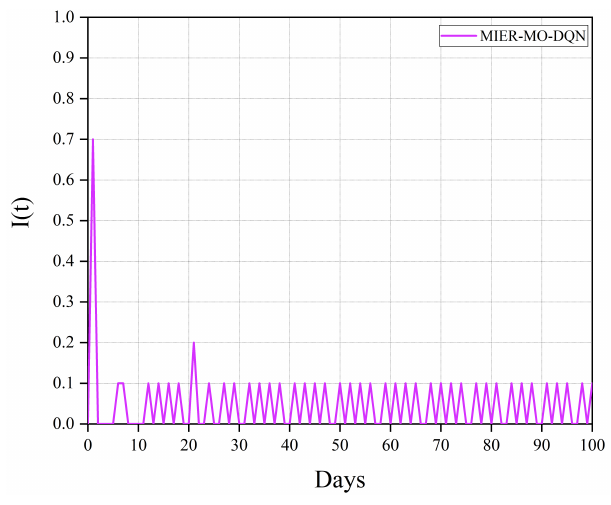
Figure 8. Drug dose of MIER-MO-DQN algorithm in Scenario 2. Table 4. Comparison of experimental indicators in different